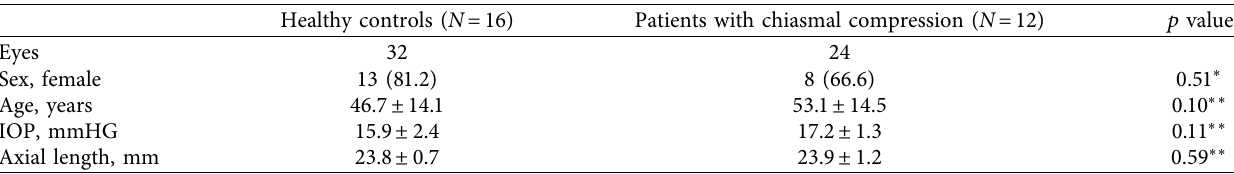
Figure 2: Flowchart of eligible and excluded patients and healthy Table 1: Demographic characteristics of study participants.